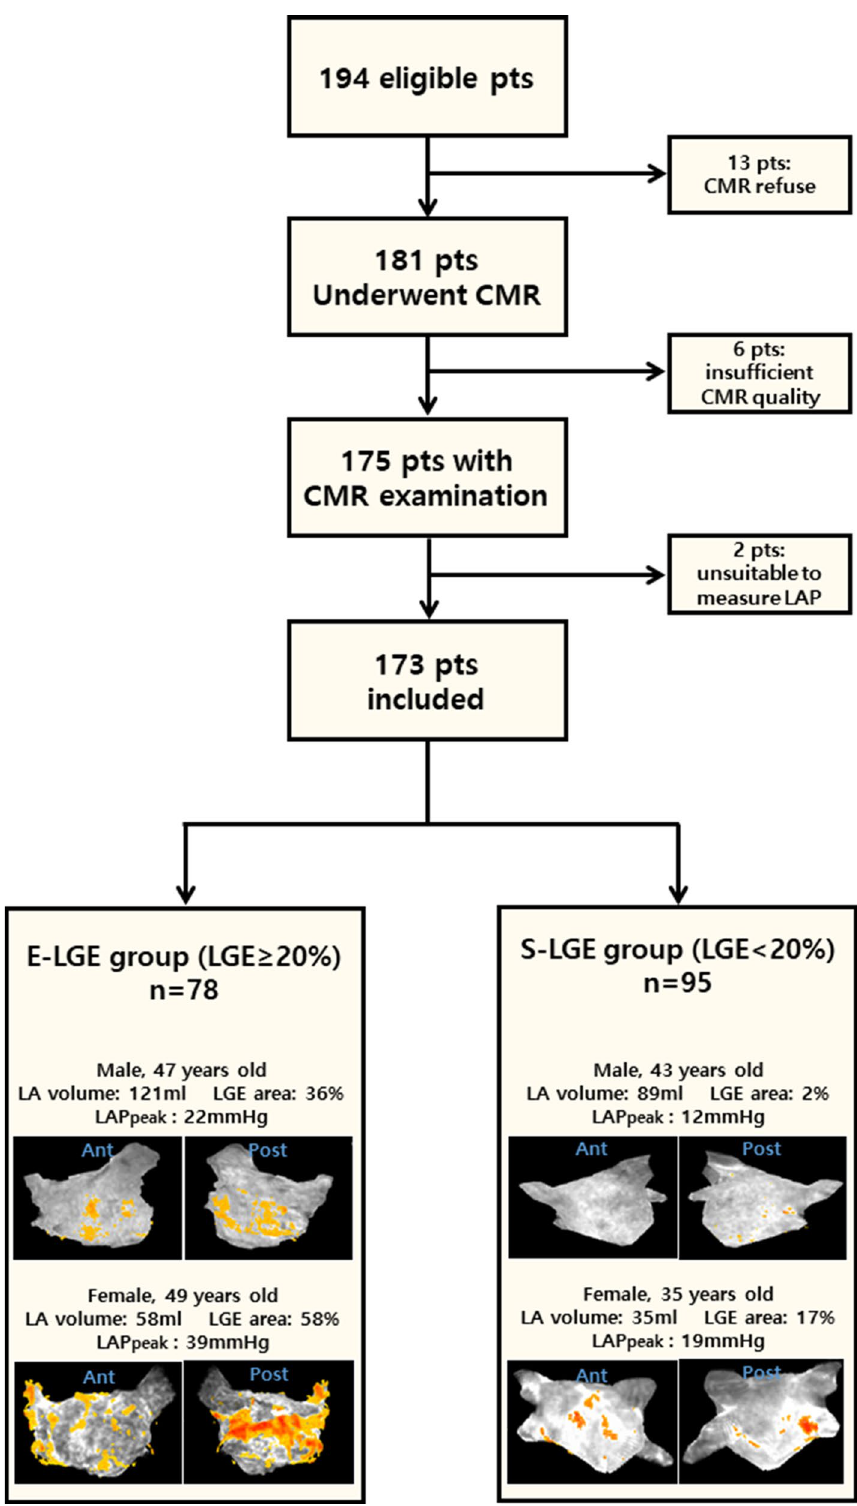
Figure 1. Flow chart showing the study design and representative LGE-CMR images of the E-LGE and S-LGE groups. Pts patients, CMR cardiac magnetic resonance, LAP left atrial pressure, LGE late gadolinium enhancement, LA left atrial, LAP left atrial pressure, Ant anterior, Post